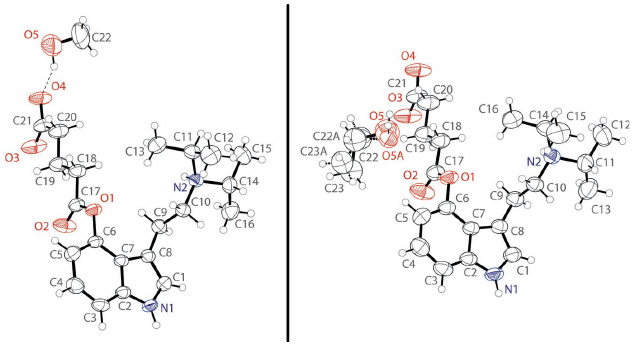
Figure 1 The molecular structures of 4-glutarato- N , N -diisopropyltryptamine as both its methanol (left) and ethanol (right) solvate, showing atomic labeling. Displacement ellipsoids are drawn at the 50% probability level. Hydrogen bonds are shown as dashed lines. Dashed bonds indicate the minor occupancy disordered component in the ethanol